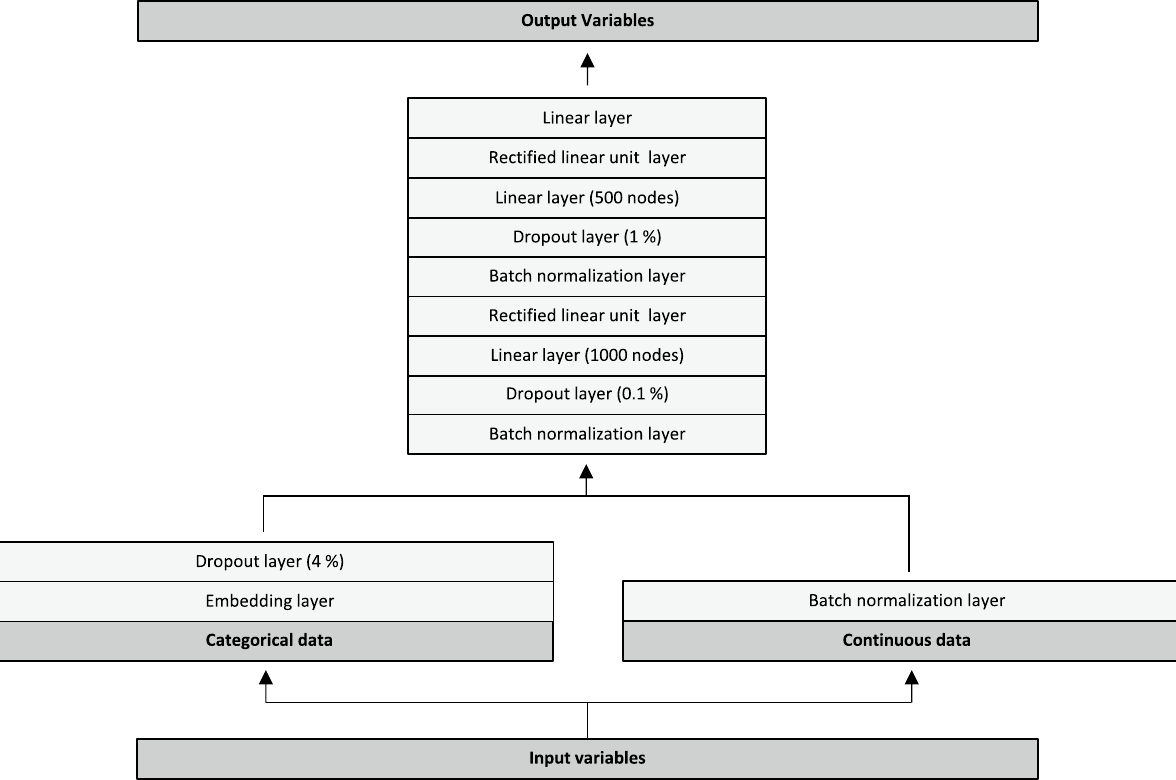
Figure 3. Neural network architecture. Input variables were split into categorical- and continuous data. Categorical data were passed through trainable embedding matrices followed by a 4% dropout layer. Continuous variables were passed directly through a batch normalization layer. Subsequently, values from the categorical and continuous trajectories were combined into another batch normalization layer. This was followed by a dropout of 0.1%, a linear layer with 1000 nodes and a rectified linear unit (ReLU) layer. Data were then passed through a batch normalization layer, a dropout of 1%, a linear layer with 500 nodes and another ReLU layer. Lastly, the data was passed through a linear layer with 19 outputs, one for each of the output variables (18 outputs for the In-Hospital